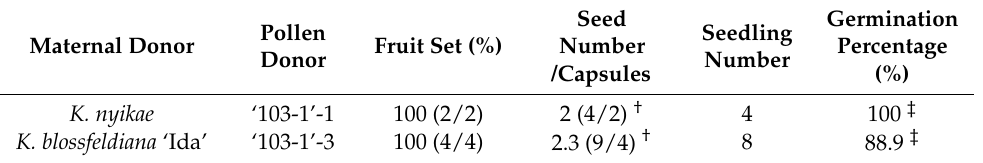
produce seedling by crossing with K. blossfeldiana cultivar or backcrossing with K. nyikae . Maternal Donor